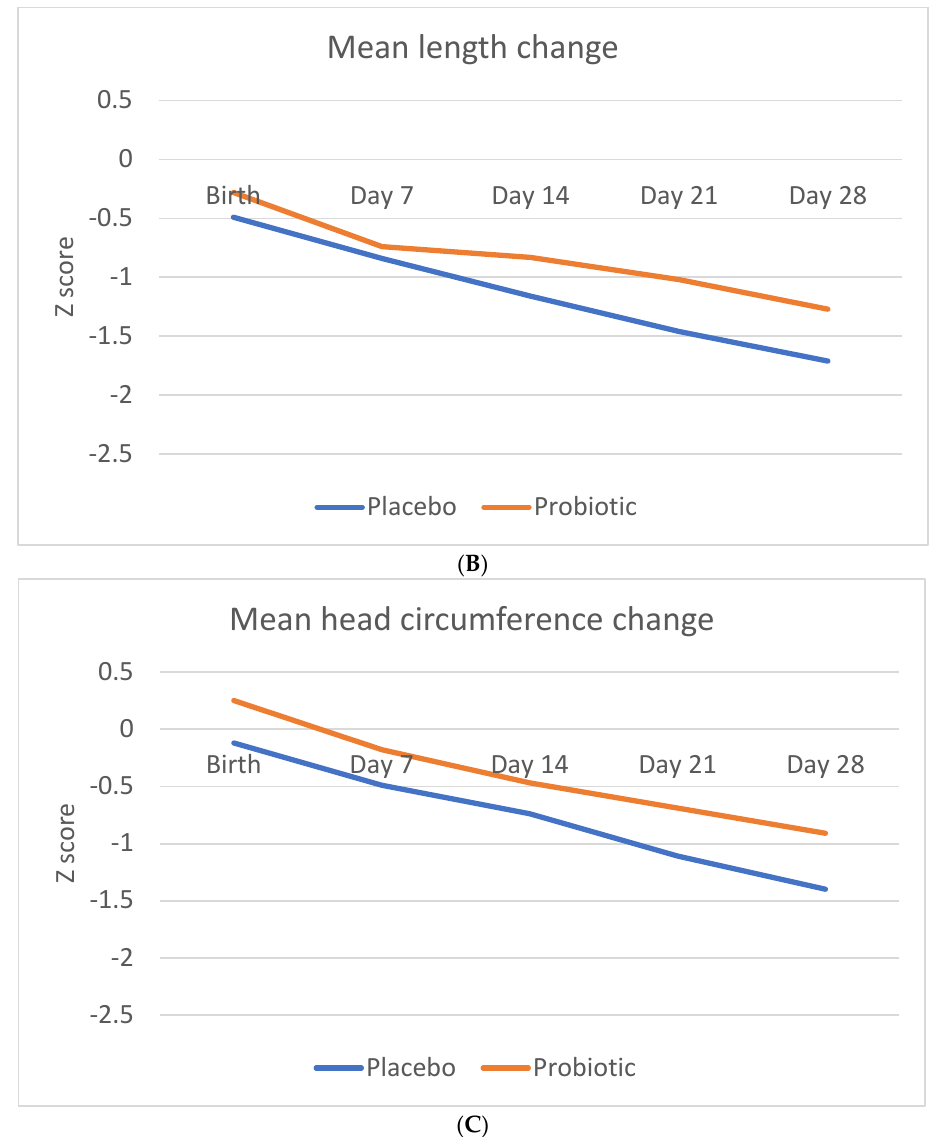
Figure 2. Change in anthropometric measurement Z ‐ scores during the study period . ( A ) Mean Z ‐ score change in weight ( B ). Mean Z ‐ score change in length ( C ). Mean Z ‐ score change in head circumference Table 5 indicates the weight, length, and head circumference Z ‐ score change over time and at the different time points. The Z ‐ score change in weight was statistically sig ‐ nificant in probiotic group from day 21 onwards, as well as over time. There was no significant difference in Z ‐ score change in either the length or head circumference between the two groups.